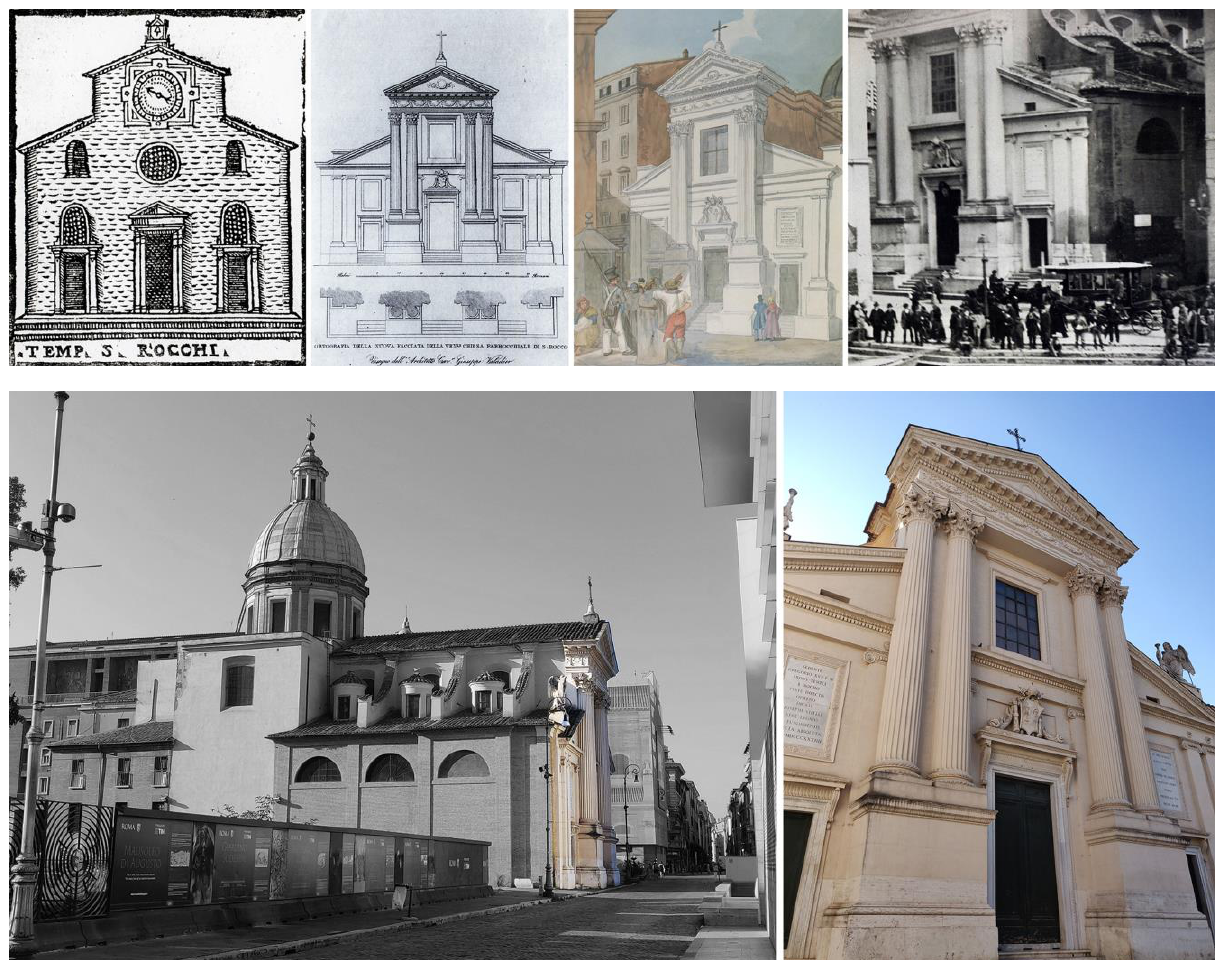
Figure 1. In the high image sequence, the historical sources relating to the San Rocco façade evolution, at the bottom the actual façade and the inclusion in the Roman building